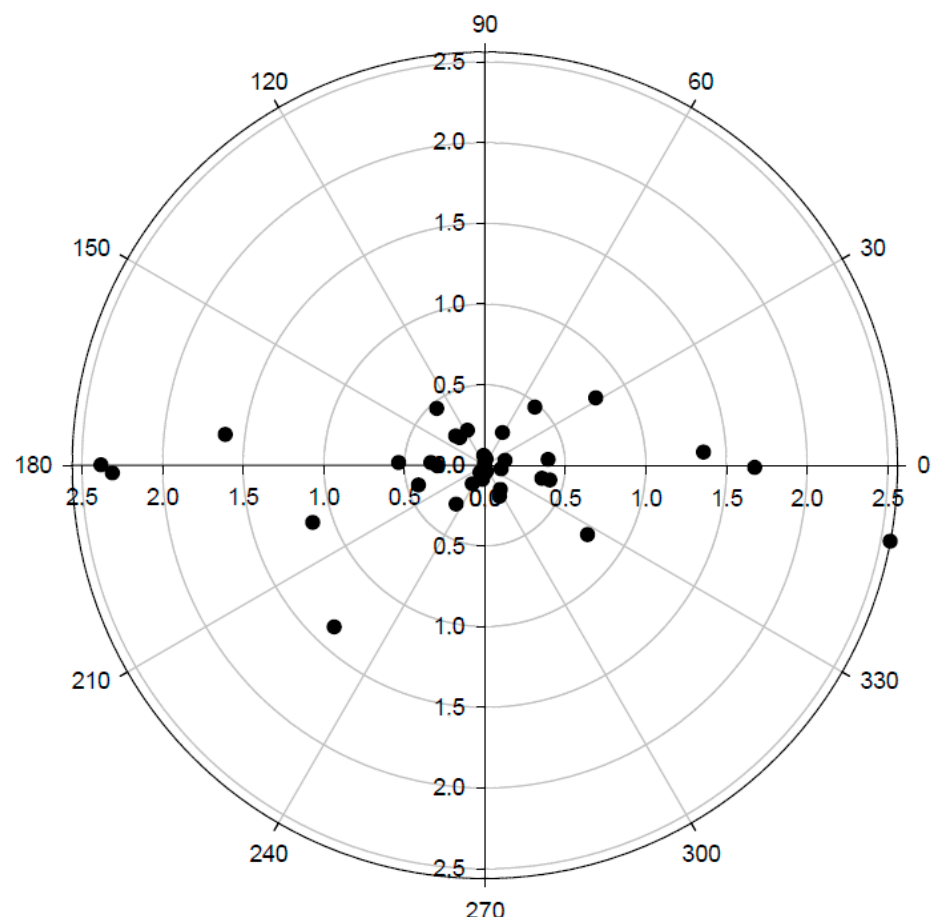
Figure 3. Polar plot showing the trending ability. This was obtained by converting CO variation obtained between T1 and T2 from PiCCO System (X-axis) and MstCare system (Y-axis). Radial sector limits, excluding data within 10% of CO variation, identify a good trending ability.